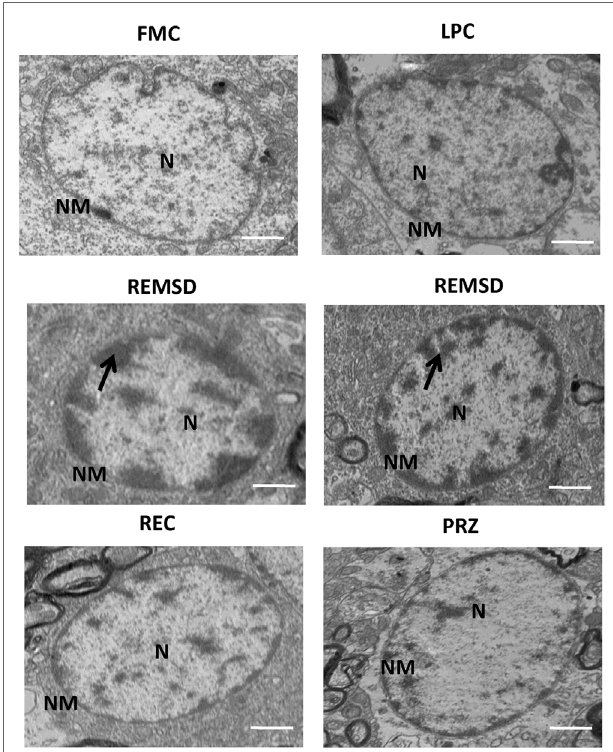
FigUre 13 | electron photo-micrograph (2,500 × ) of nucleus in lc neurons of rat brains treated under different conditions . Nucleus and chromosomes appear normal in FMC and LPC. Images of two different rat brains after REMSD are shown as compared to one each from other control rat brains. Neuron with chromatin condensation can be seen in the REMSD rat brains. The dark arrows point to areas near nuclear membrane with increased chromatin condensation. Reduced degenerative changes of nucleus were seen in the REC- and PRZ-treated rat brains. N – nucleus, NM – nuclear membrane; scale bar: 500